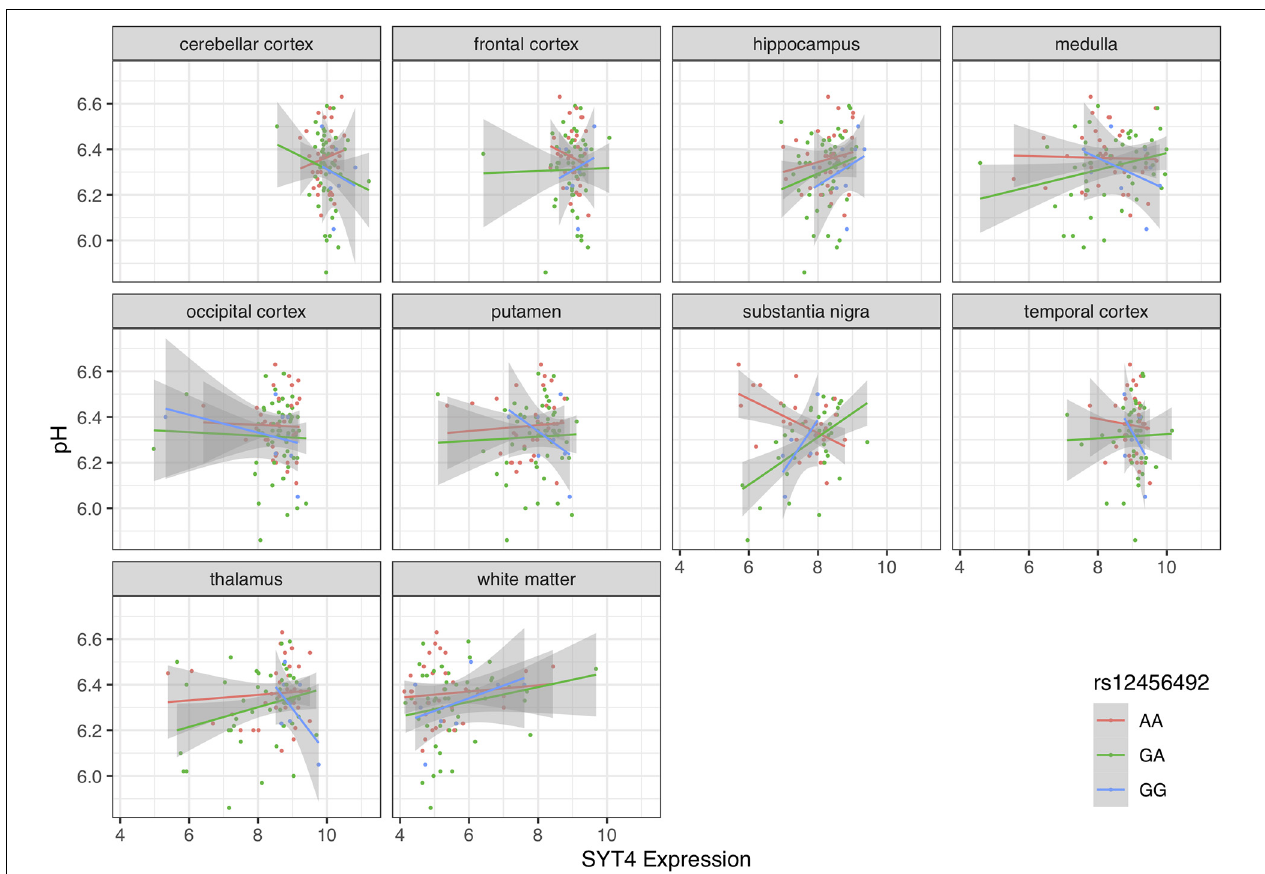
FIGURE 5 | Scatter plot of pH and SYT4 gene expression based on rs12456492 genotype for 10 brain regions. Genotype groups are colored with lines representing linear fits with shaded areas marking the 0.95 confidence intervals.